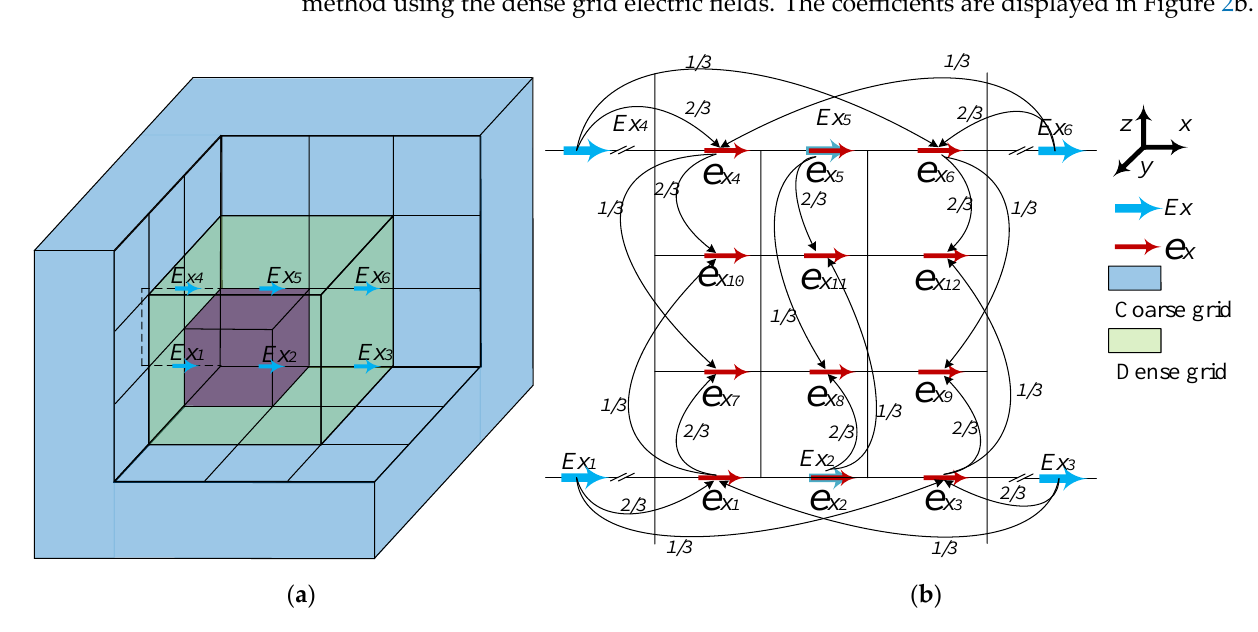
Figure 2. ( a ) The subgridding interface in three dimensions and ( b ) the x-component electric field interpolation schematic diagram in the x – z plane.